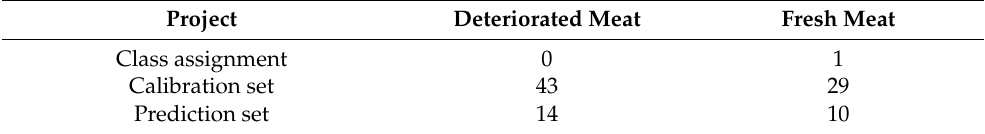
Table 1. Class assignments of pork and their distributions in calibration and prediction sets.